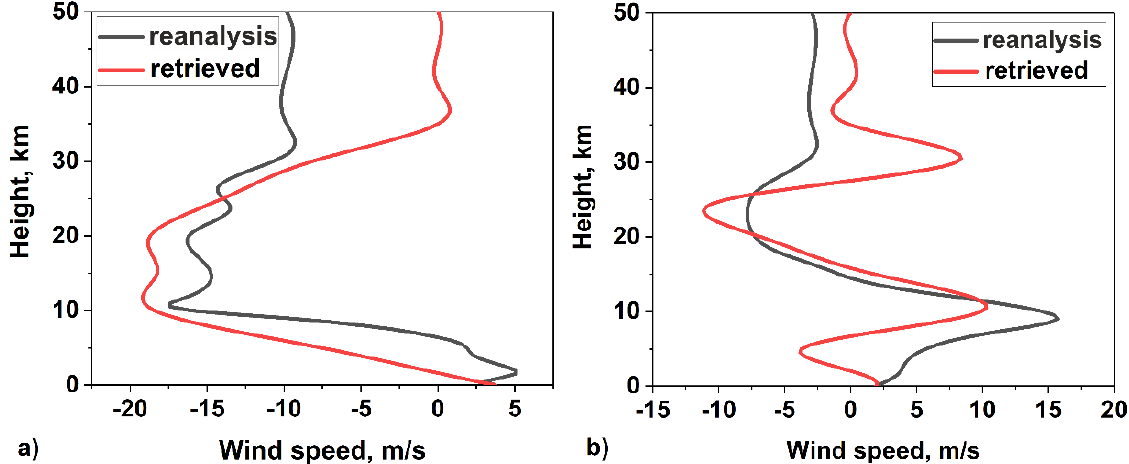
Figure 7. Vertical profiles of the wind speed projection on the line of sight (red curves) ( a , b ) retrieved from measured atmospheric spectra, which are demonstrated in Figure 5a,b, respectively. Black curves are the reanalysis data. The retrievals’ precision is about 3–5 m/s with a vertical resolution of half of the height scale. (For interpretation of the references to color in this figure, the reader is referred to the web version of this article).